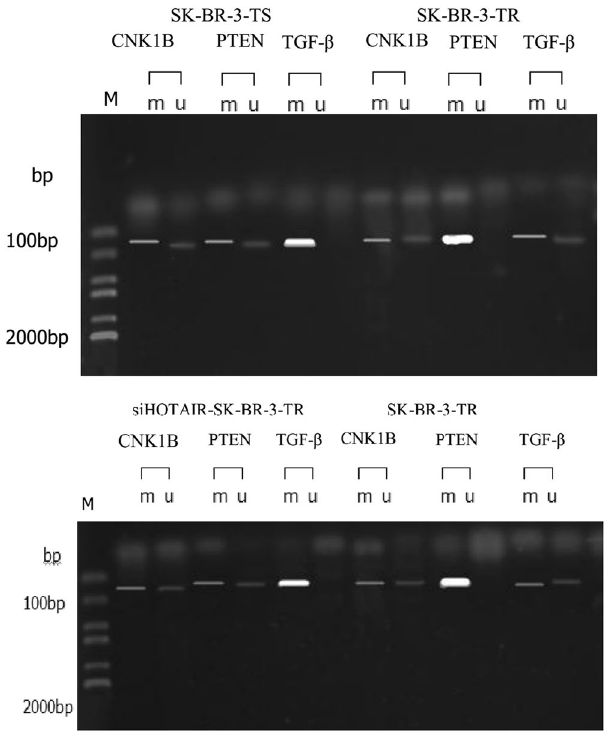
Figure 8. Methylation of P27, PTEN and TGF- β genes in SK-BR-3-TR cells following HOTAIR